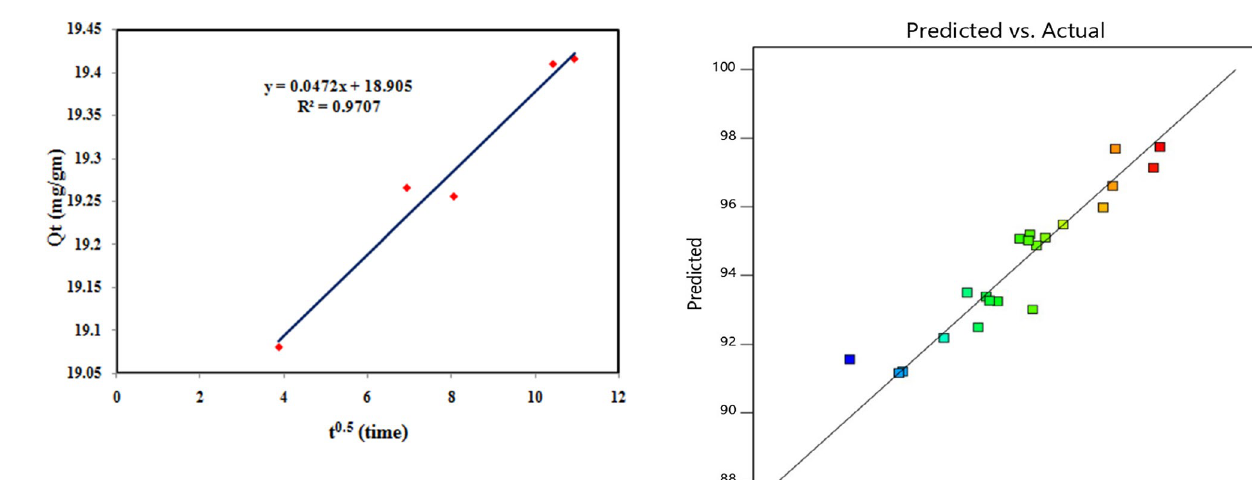
Fig. 16 Mass transfer model for MG Sorption process on NLP adsor- bent (NLP: 3 g/l, MG: 100 mg/l, Temp: 308 K)